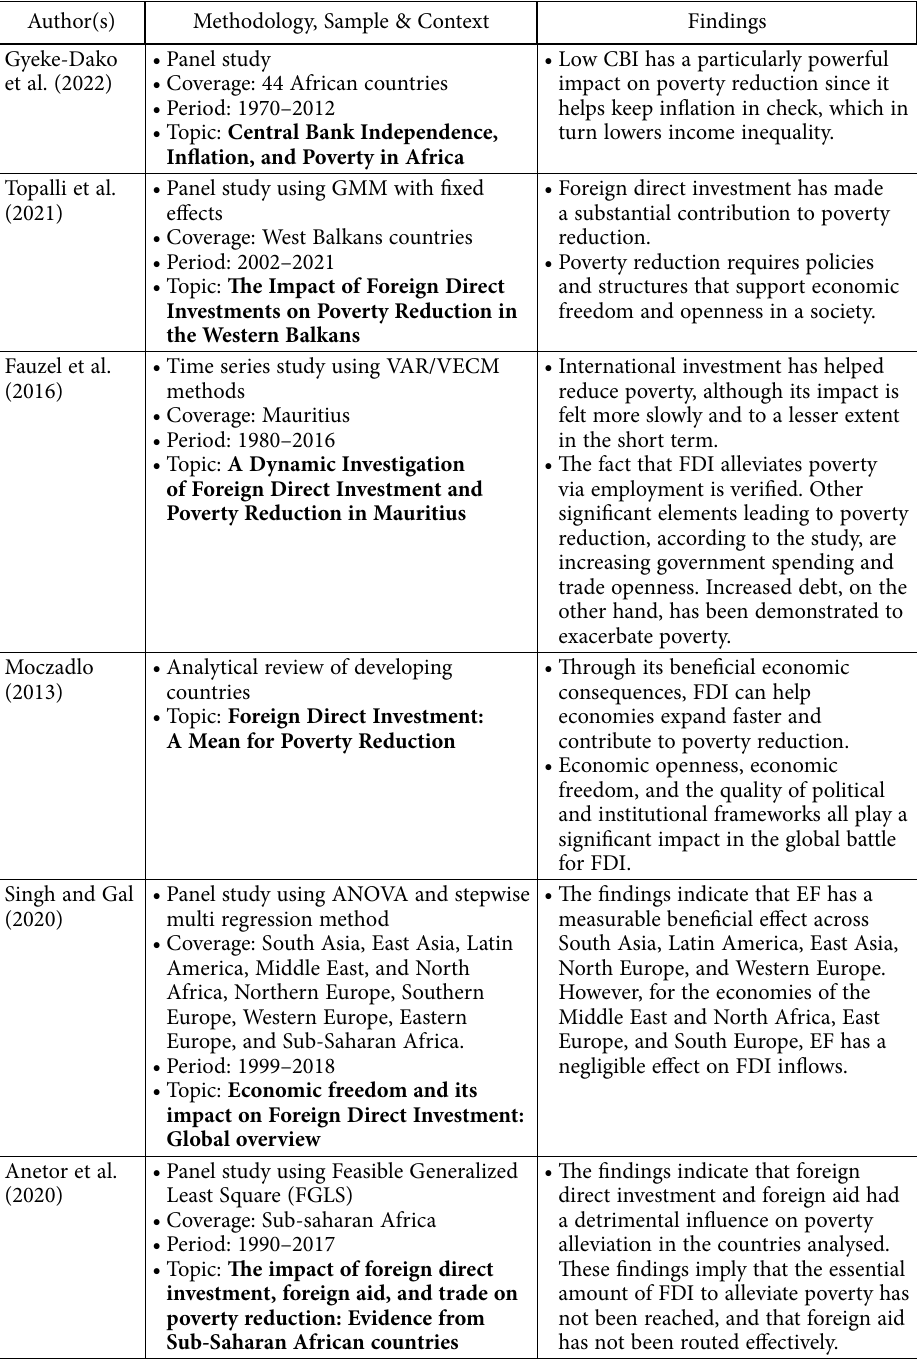
Table 2. A compilation on recent literature that addresses the study